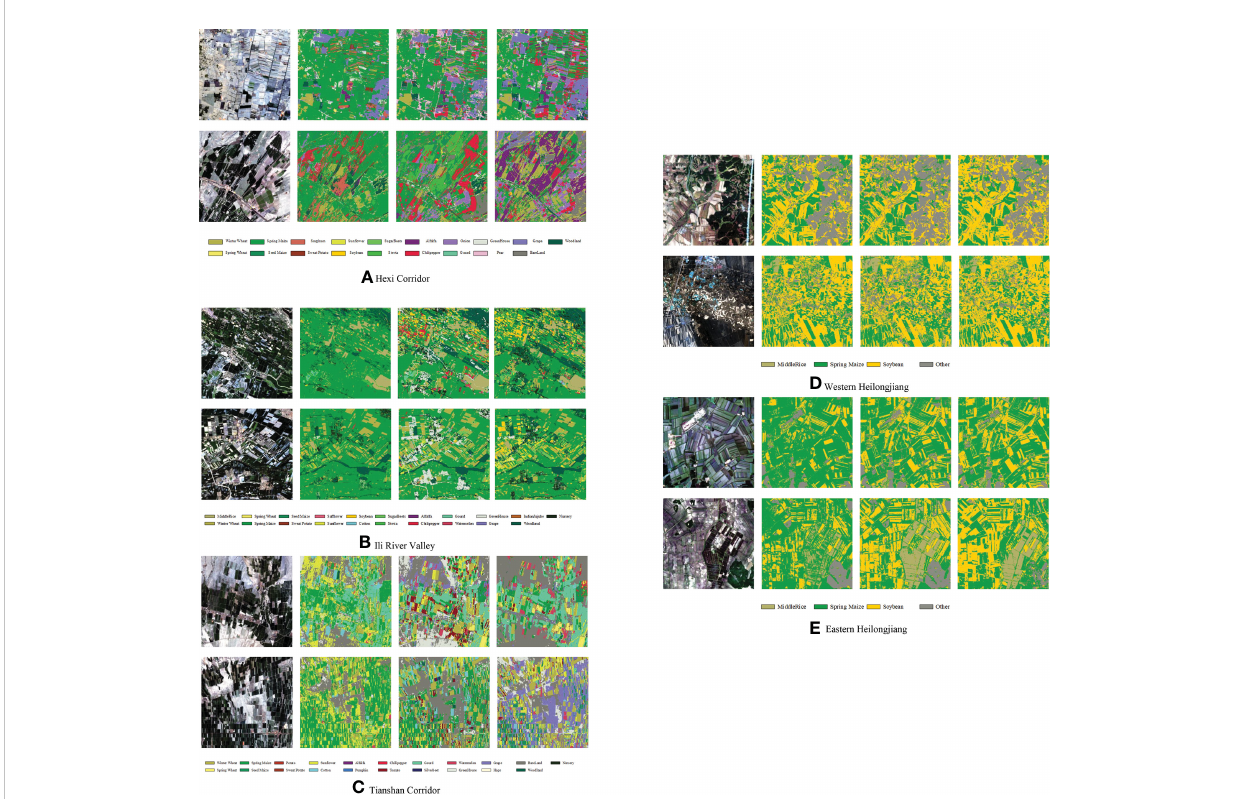
FIGURE 11 Map of crop distribution in selected areas of the fi ve study areas. For each study area, from left to right, remote sensing images, RF mapping, SIFT- BERT mapping, and Cropformer